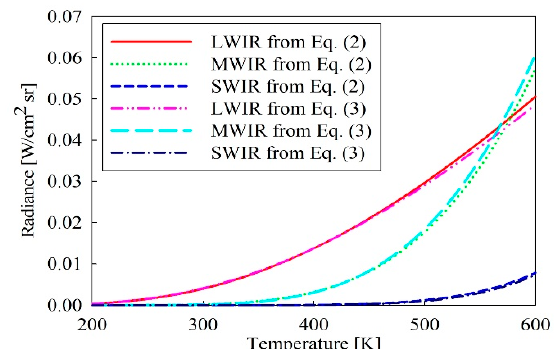
Figure 5. Exact and approximated radiance according to temperature for three IR wavelength bands.